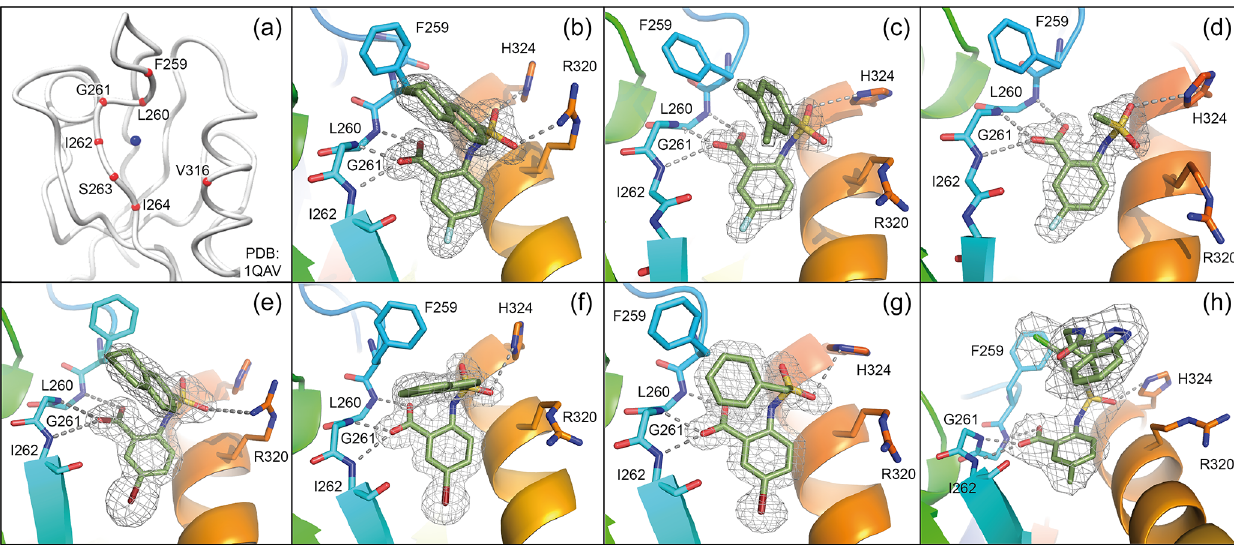
Figure 1. (a) Definition of PDZ binding site. The centre of the binding site (blue sphere) is defined as the geometric centre of C α atoms (red spheres) of seven residues (typed in red) defined by multiple sequence alignment. (b–h) Magnified views into crystal structures of various compounds bound to the Dvl-3 PDZ domain. The 2Fo-Fc electron density around the compounds is shown at 1 σ contour level, and the dotted lines indicate formed hydrogen bonds. In the bound compounds covalent bonds to carbon atoms are shown as green sticks. Important residues involved in compound binding are labelled and displayed in atom colours (carbons blue or dark yellow). Panels (b–d) show compound 3 , 5 , and 6 , respectively. All compounds in (b–d) contain fluorine (light blue) in para position to the amine. Panels (e–g) represent the bound compounds 7 , 11 , and 12 , respectively. All have bromine (dark red) in para position to the amine. Panel (h) shows compound 18 within the binding site. The accession codes of the structures (b–h) are 6ZBQ, 6ZBZ, 6ZC3, 6ZC4, 6ZC6, 6ZC7, and 6ZC8,